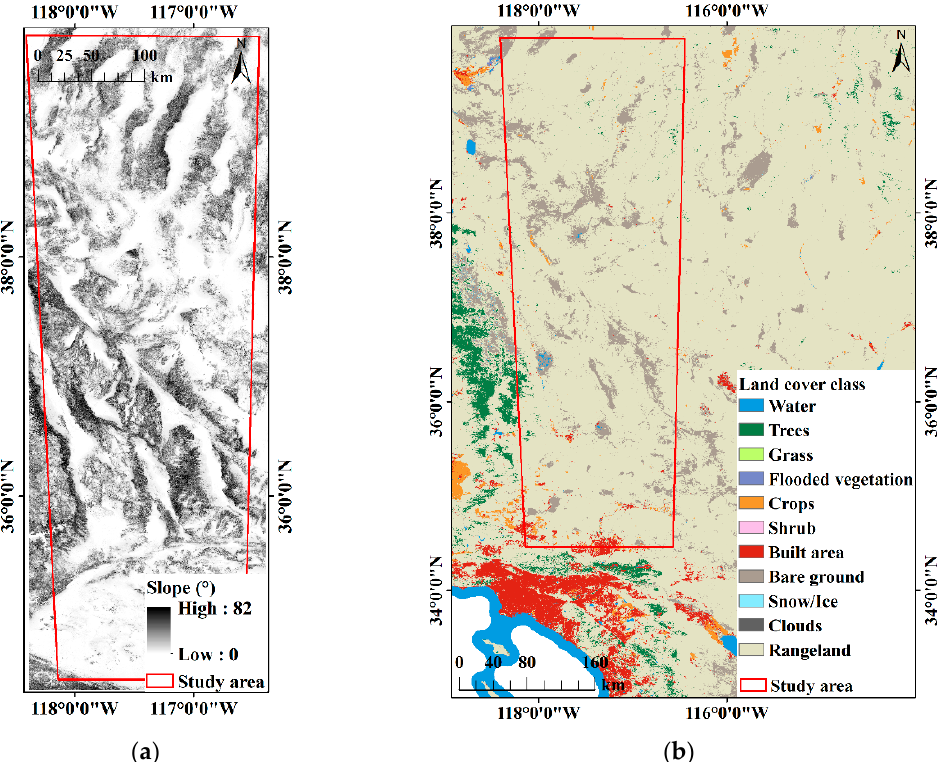
Figure 2. Topographical characteristics of the study area. ( a ) Terrain slope; ( b ) land cover types.